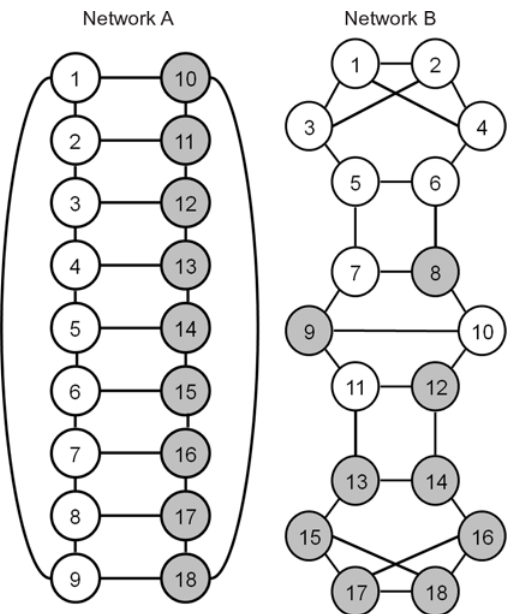
Fig 1. Networks with same degree distribution and proportion cross racial